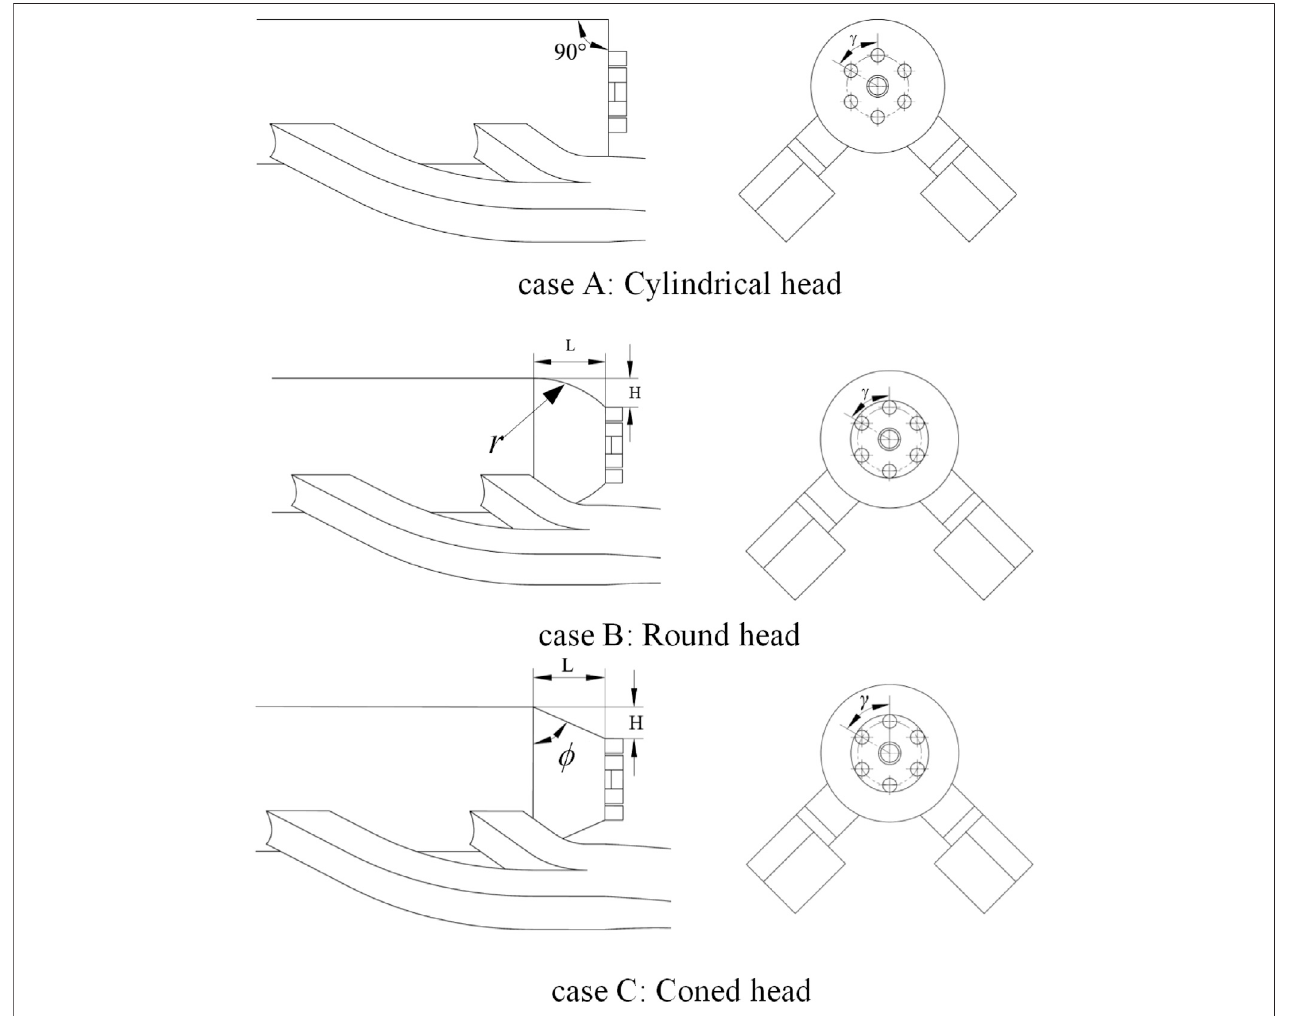
FIGURE 3 | Different designs of head shapes of the combustion